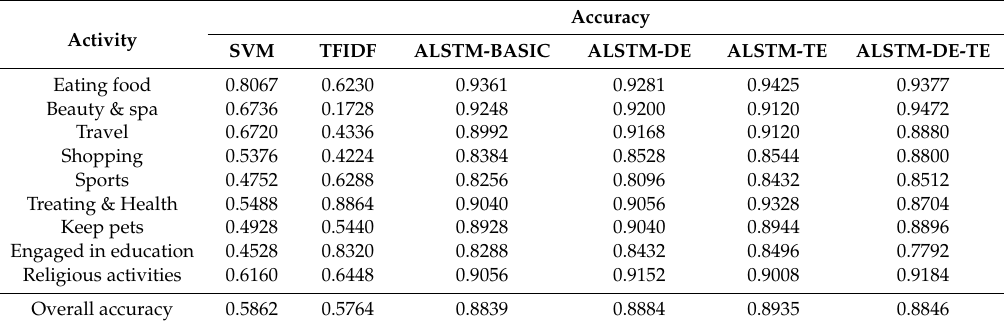
Table 6. Accuracy of the selected 9 category